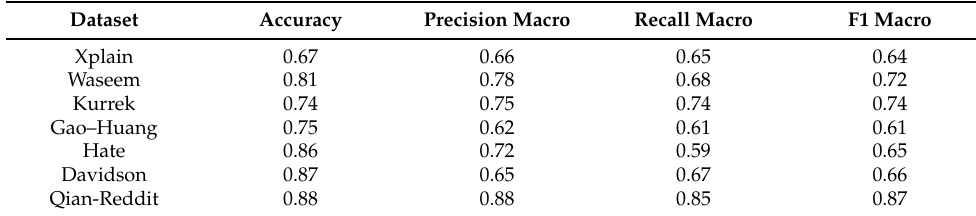
Table A3. Scores obtained on the benchmark Datasets using the decision trees algorithm. Dataset